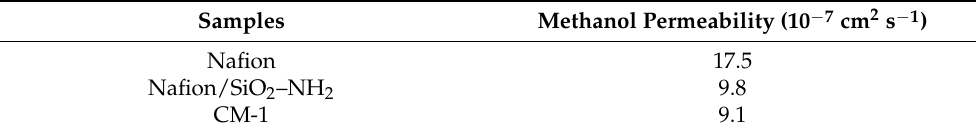
Table 1. The methanol permeability of Nafion, Nafion/SiO 2 –NH 2 , and CM-1.